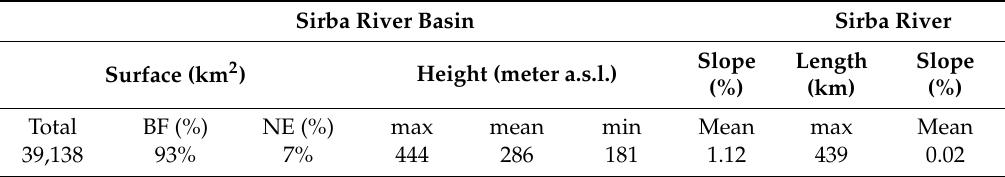
Table 1. Physical features of the Sirba River Basin and of the Sirba River.